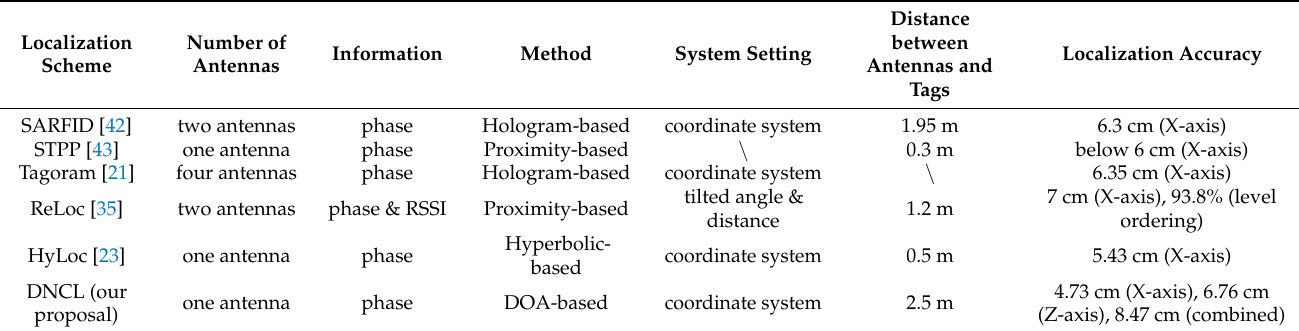
Table 1. Comparison of the common RFID localization